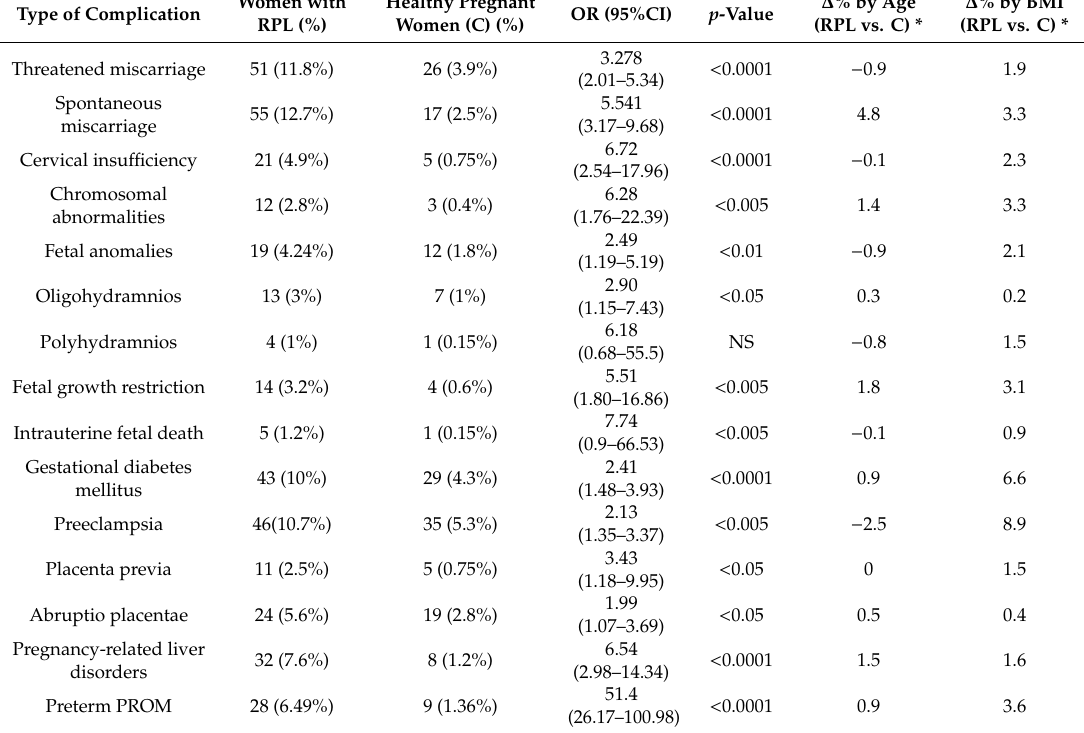
Table 3. Pregnancy complication rates in women with RPL and control women. The factorial analysis of the e ff ect size of age and BMI is reported as ∆ % of the whole study